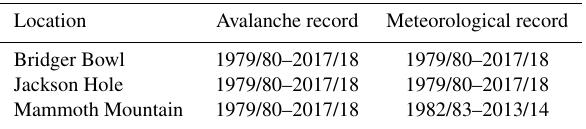
Table 1. Length of avalanche and meteorological records used at each study site.